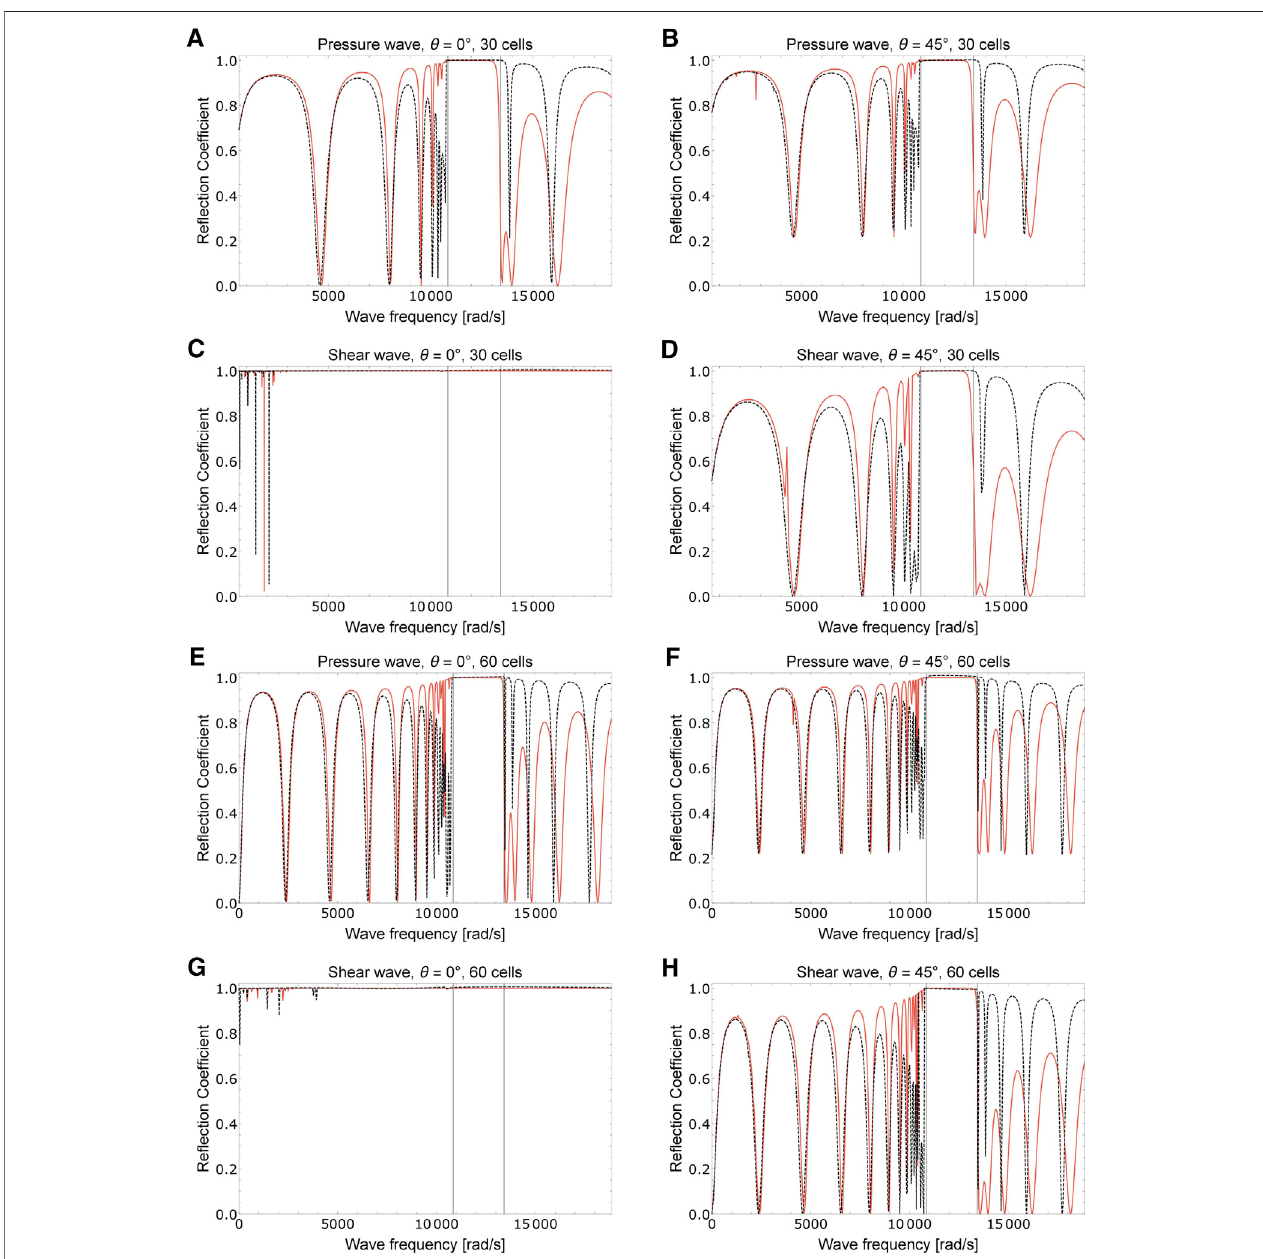
FIGURE10| Comparison ofthemicrostructure ’ s(dashed blackline)and micromorphic (redline)re fl ectioncoef fi cientasafunctionoffrequencyfora30 (A – D) and a 60 (E – H) unit cells slab of MM1 and embedded in CM1 . (A) and (E) “ pressure ” normal incident wave with respect to the slab ’ s interface for a 25 and 30 cells respectively. (B) and (F) “ pressure ” 45 ° incident wave with respect to the slab ’ s interface for a 25 and 30 cells, respectively. (C) and (G) “ shear ” incident wave normal to the slab ’ s interface for a 25 and 30 cells, respectively. (D) and (H) “ shear ” 45 ° incident wave with respect to the slab ’ s interface for a 25 and 30 cell,s